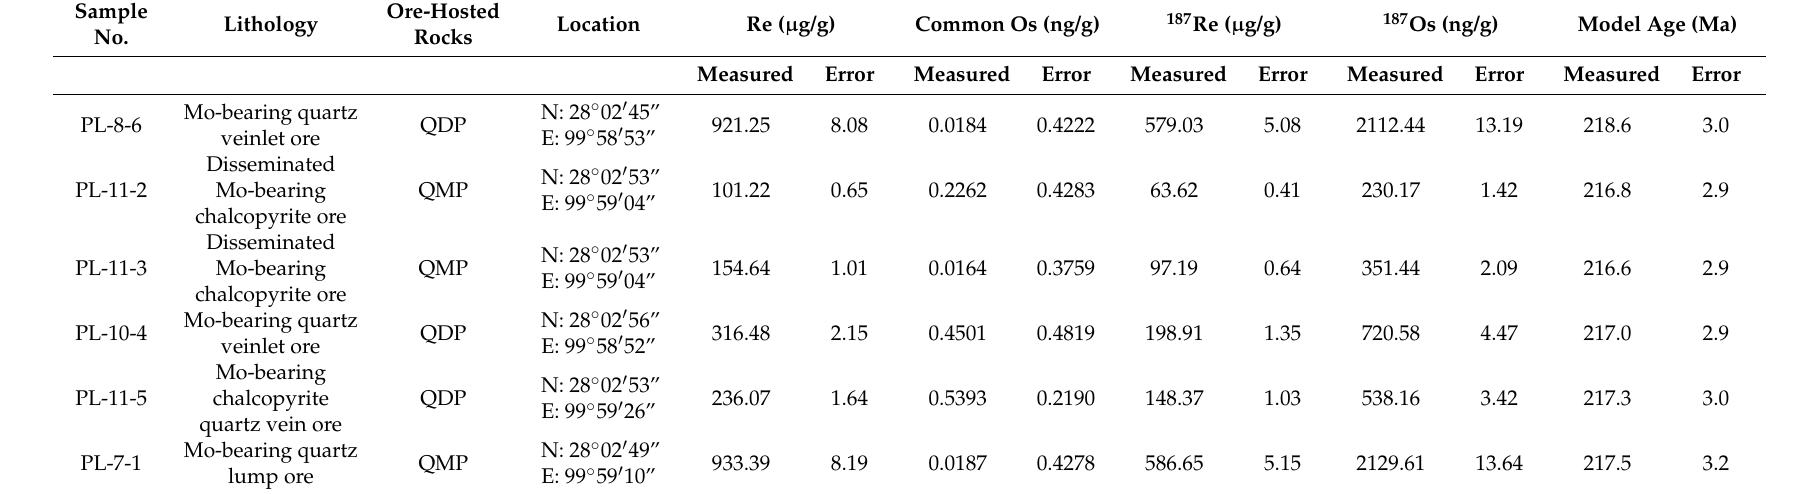
Table 2. Molybdenite Re–Os dating results in the Pulang Cu (–Mo–Au)